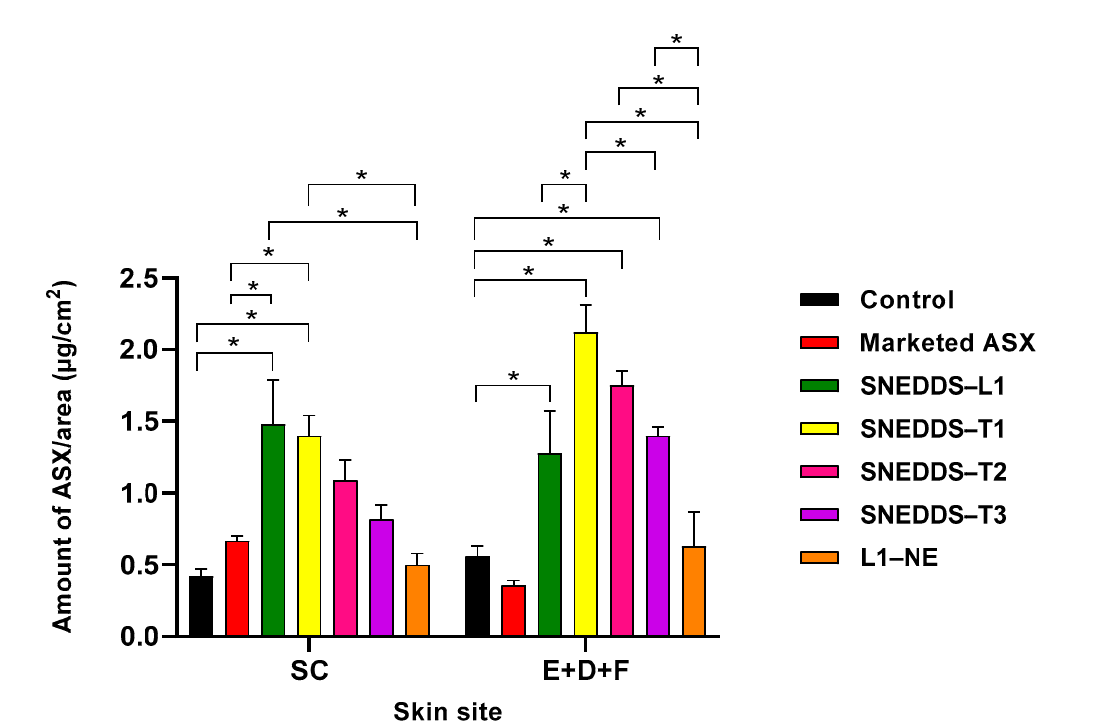
Figure 3. Skin penetration profile of SNEDDS formulations compared to marketed topical product and ASX in oil control: the distribution of ASX in the SC and E+D+F; (mean ± SEM; n = 9; * p < 0.05).